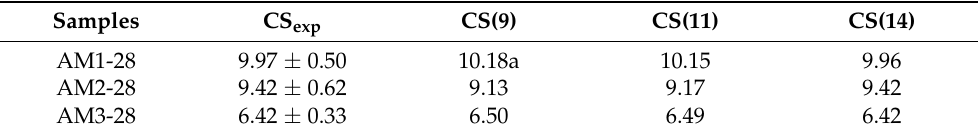
Table 6. Compressive strength CS (MPa) of metakaolins alkali-activated for 28 days experimental ( CS exp ) and predicted CS using Equations (9), (11) and